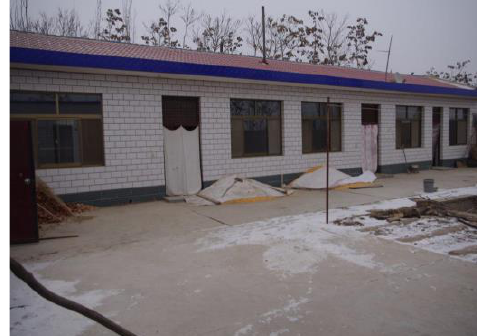
Figure 1. A typical residential building in Ningxia.